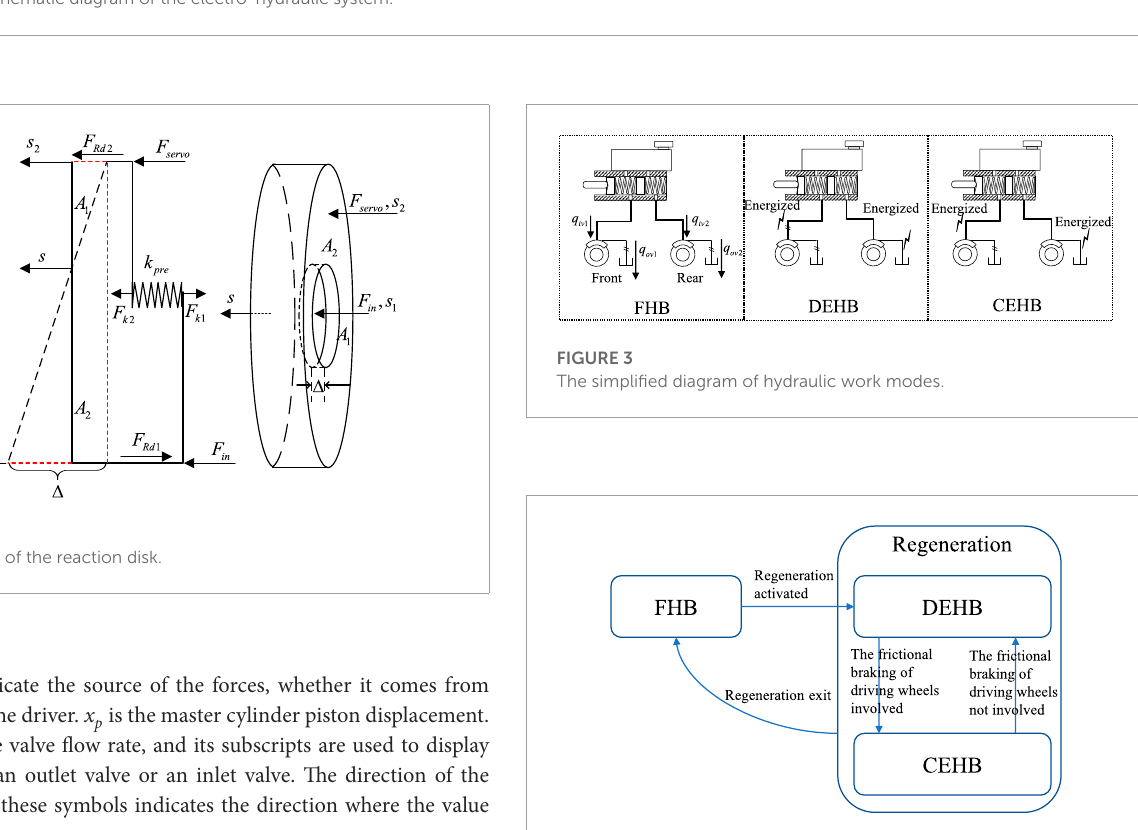
FIGURE 4 State machine for the control